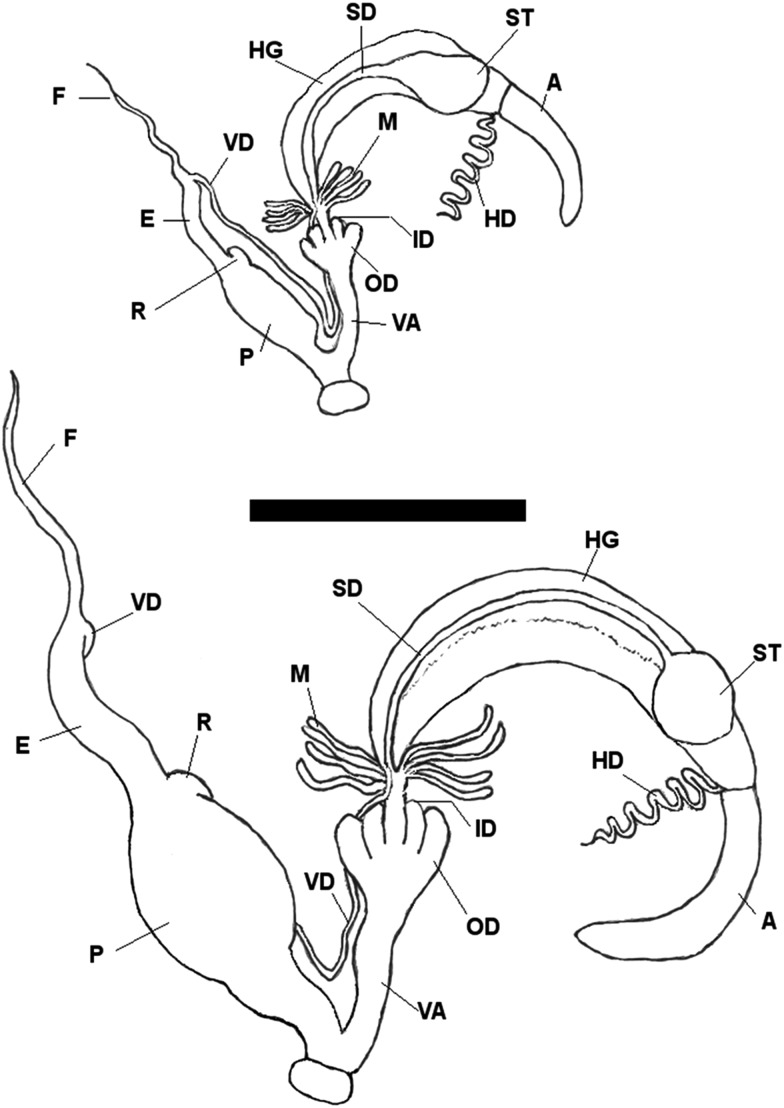
Genital duct of Trochulus oreinos (top) and T. striolatus (bottom). Abbreviations: A, albumen gland; E, epiphallus; F, flagellum; HD, hermaphroditic duct; HG, hermaphroditic gland; ID, inner dart sacs; M, mucous glands; OD, outer dart sacs; P, penis; R, retractor muscle; SD, spermathecal duct; ST, spermatheca; VA, vagina; VD, vas deferens.